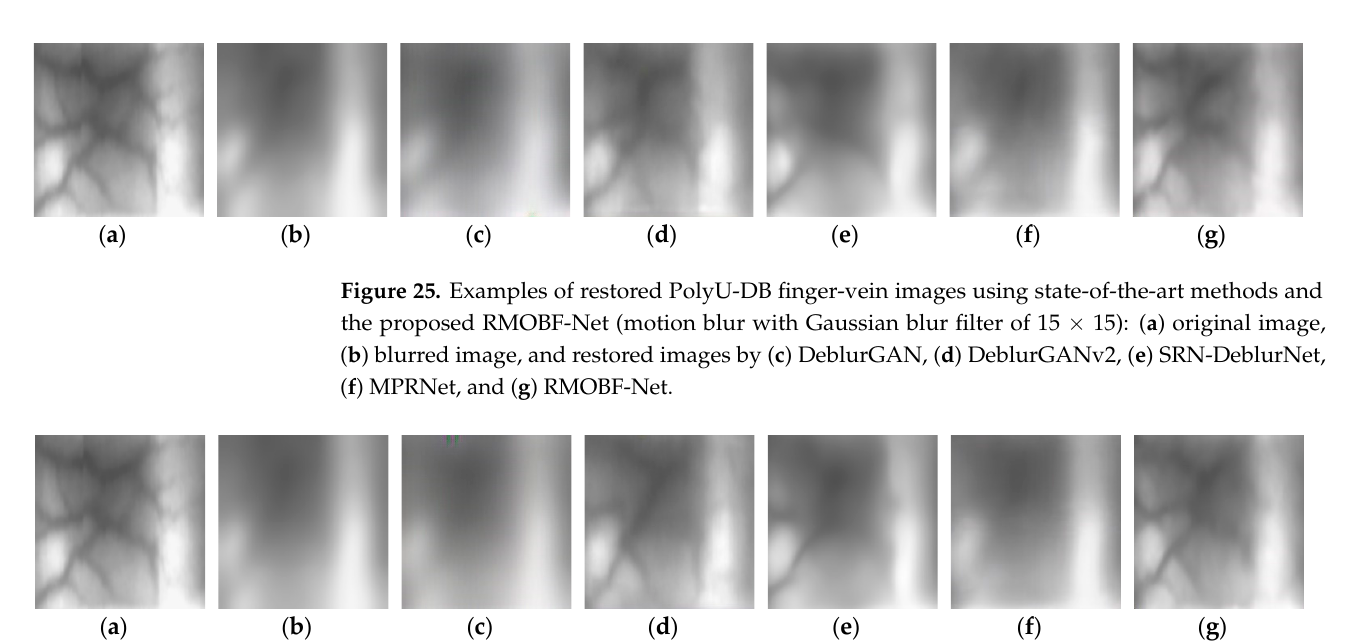
Figure 24. Examples of restored PolyU-DB finger-vein images using state-of-the-art methods and the proposed RMOBF-Net (motion blur with Gaussian blur filter of 11 × 11): ( a ) original image, ( b ) blurred image and images restored by ( c ) DeblurGAN, ( d ) DeblurGANv2, ( e ) SRN-DeblurNet, ( f ) MPRNet, and ( g ) RMOBF-Net.